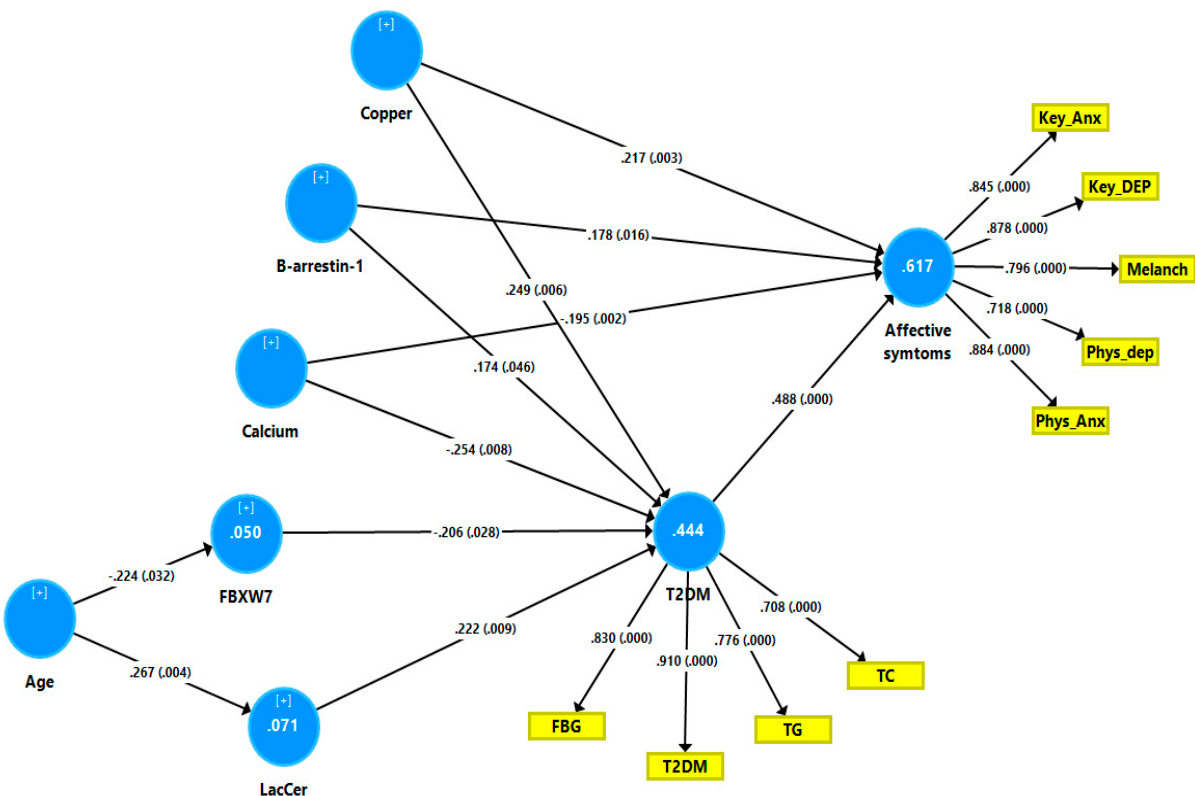
Figure 4. Results of partial Least Squares (PLS) path analysis. Shown are the significant path coefficients with exact p -values, and the explained variances (white figures in the circles). LacCer: lactosylceramide; FBG: fasting blood glucose; T2DM: type 2 diabetes mellitus; TG: triglycerides; TC: total cholesterol; Key_Dep: key depressive symptoms; Phys_Dep: physiosomatic symptoms of the HDRS (Hamilton Depression Rating Scale); Melanch: melancholic HDRS symptoms;